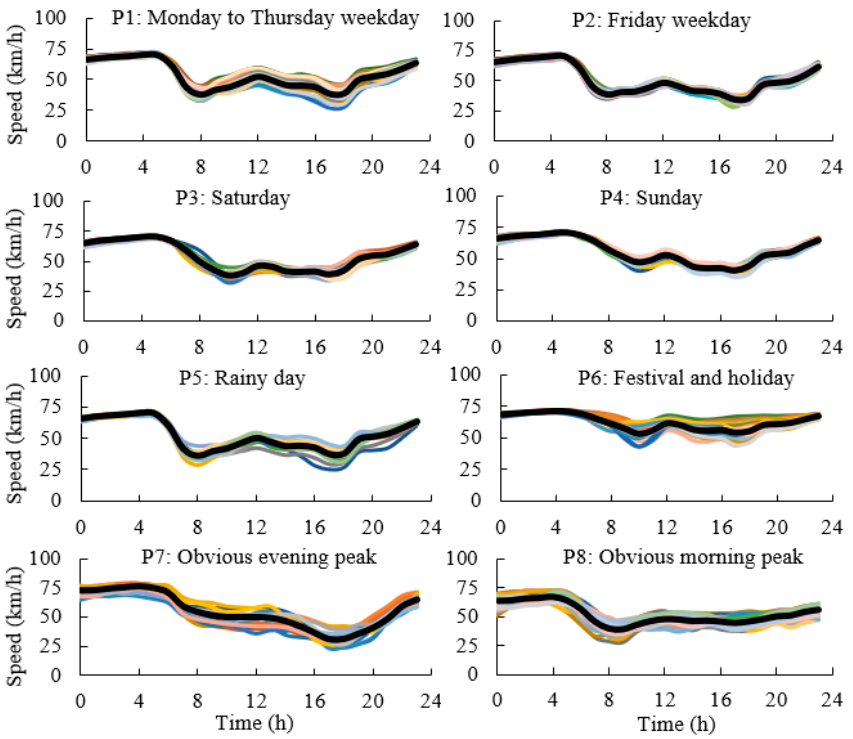
Figure 5. Clustering of expressway speed (curves with different colors mean different days).